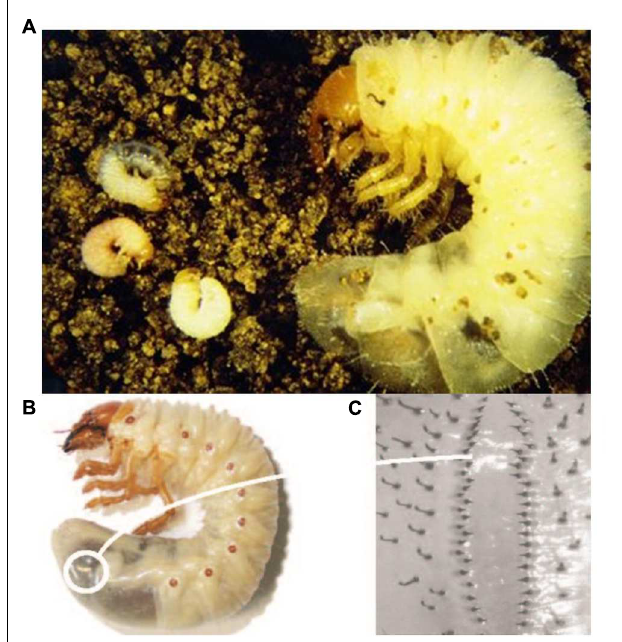
FIGURE 1 | Scarab larvae: (A) African black beetle larvae Heteronychus arator , (B) greyback cane beetle larva Dermolepida albohirtum , (C) close-up of hair pattern (raster) used to identify greyback cane beetle larvae. Images supplied by Western Australian Department of Agriculture and Food (African black beetle) and Sugar Research Australia (greyback cane beetle larva).